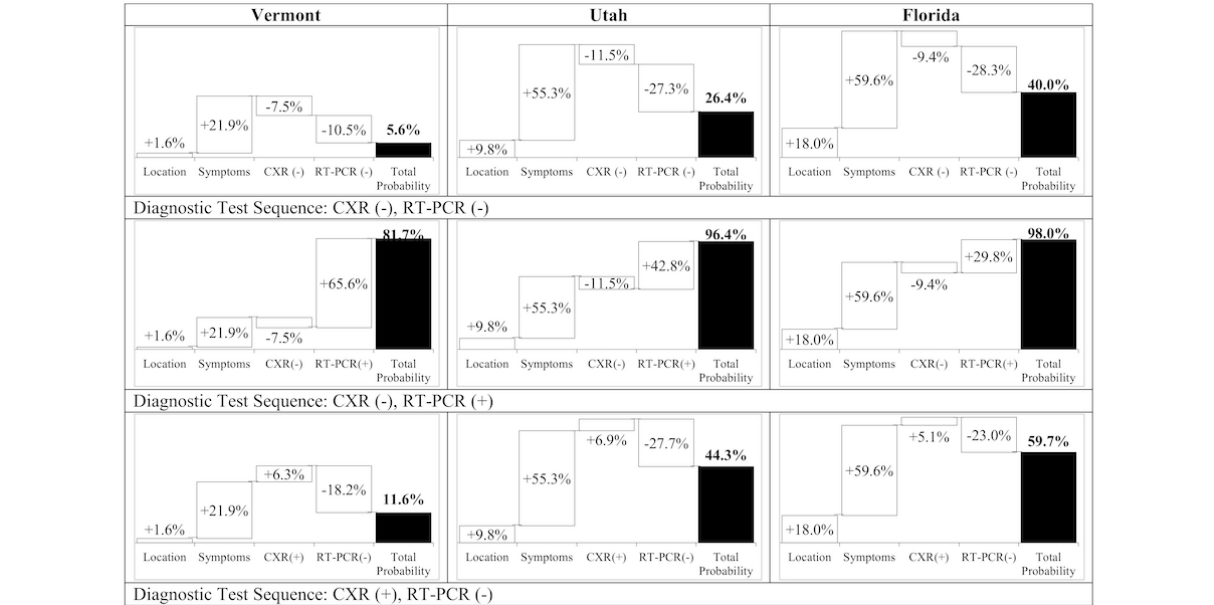
Figure 2. Impact of patient location and diagnostic test results on probability of SARS-CoV-2 infection. Prior probability of disease due to location is the estimated disease prevalence for Vermont (1.6%), Utah (9.8%), and Florida (18.0%). Incremental probability due to symptoms assumes the patient presents with only fever and dry cough. RT-PCR: reverse transcription-polymerase chain reaction; CXR: chest